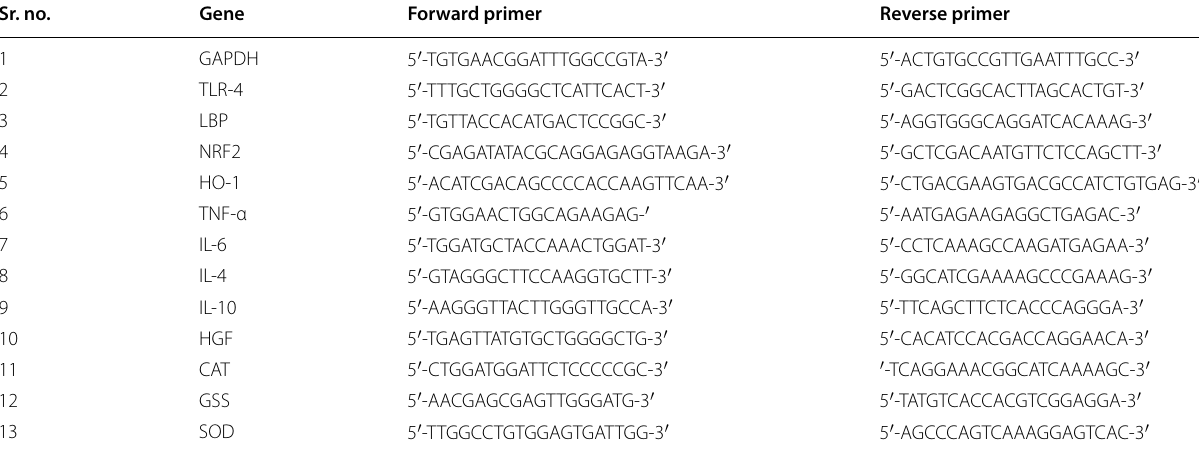
Table 1 PCR primers sequences of the genes analyzed Sr.